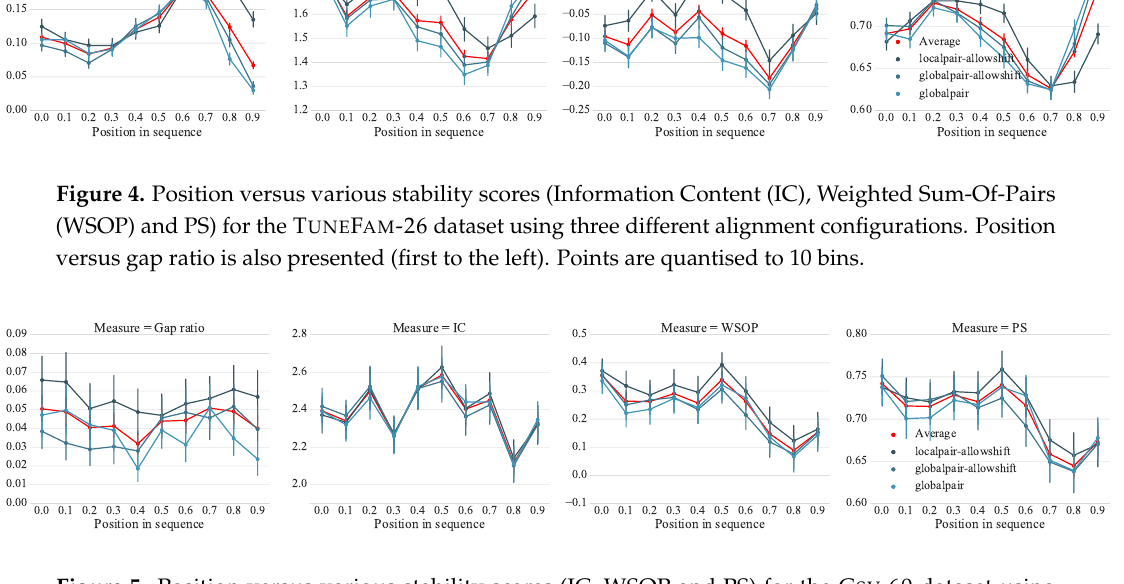
Figure 5. Position versus various stability scores (IC, WSOP and PS) for the C SV -60 dataset using three different alignment configurations. Position versus gap ratio is also presented (first to the left). Points are quantised to 10